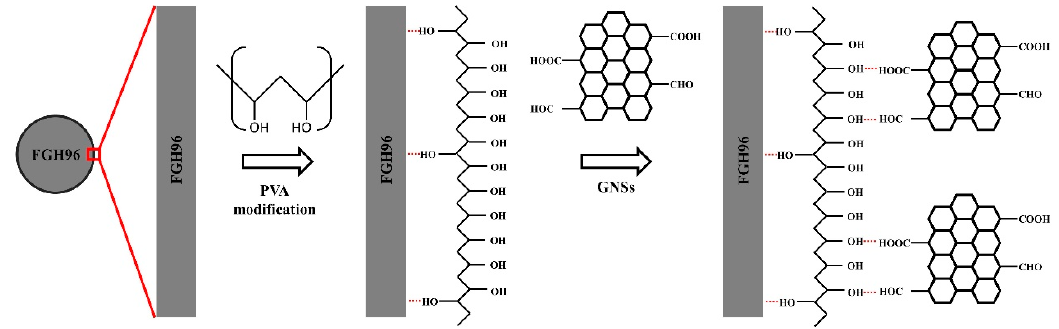
Figure 4. Diagram of the GNSs adsorption mechanism on the FGH96 powder surface.